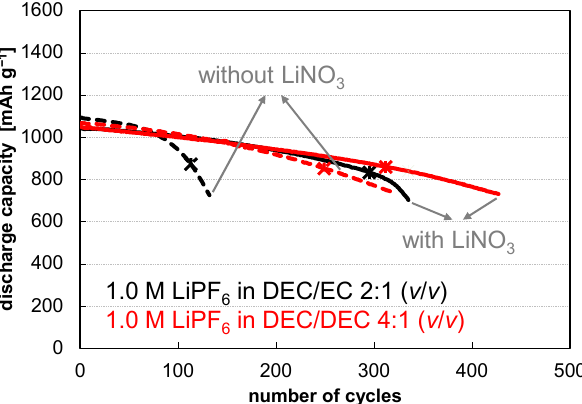
Figure 7. Cycling behavior of full cells (discharge capacity of anode active material) based on CLM00001 anodes (standard PSD) with optimal LiNO 3 loading of 0.35 g cm − 2 and two different electrolytes (solid lines in black and red) compared to similar cells without LiNO 3 in the 4.2–3.0 V range (dotted lines in black and red). The asterisks mark 80% capacity retention. The nitrate effect is also evident when EC in the electrolyte is replaced by